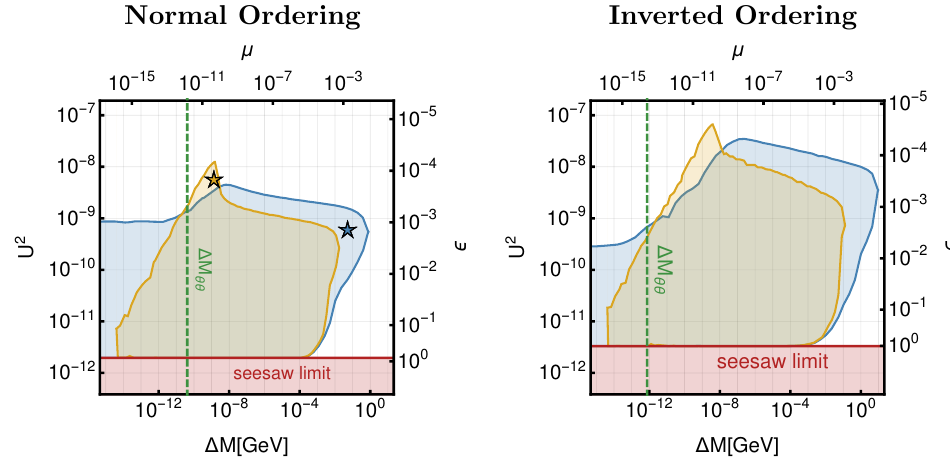
Figure 1 . Comparison of the allowed parameter range in the (cid:1) M - U 2 plane with (blue) and without (yellow) the lepton number violating processes for normal and inverted hierarchies with the benchmark mass of (cid:22) M = 30GeV. One can see that the range of the allowed mass splitting increases when lepton number violation is included by two orders of magnitude, reaching sizes that can be resolved in experiments. The blue and yellow stars correspond to benchmark points for which we present a comparison between the evolution with and without the lepton number violating processes in (cid:12)gures 2. The yellow star corresponds to a point in parameter space that can reproduce the correct the observed BAU only if one neglects the lepton number violating processes, while the blue star corresponds to a point in parameter space that can only reproduce the correct BAU if one includes the LNV